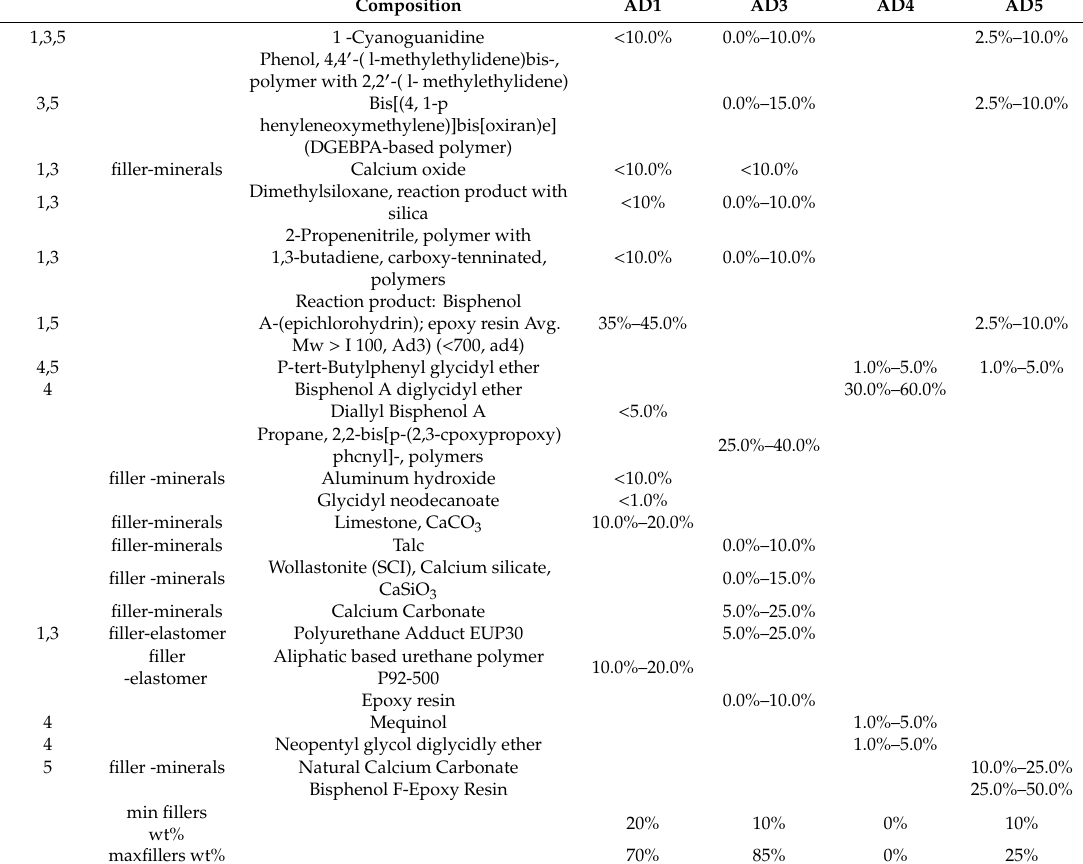
Table 2. Components of structural adhesives obtained from MSDS as provided by manufacturer and used during the second phase of the